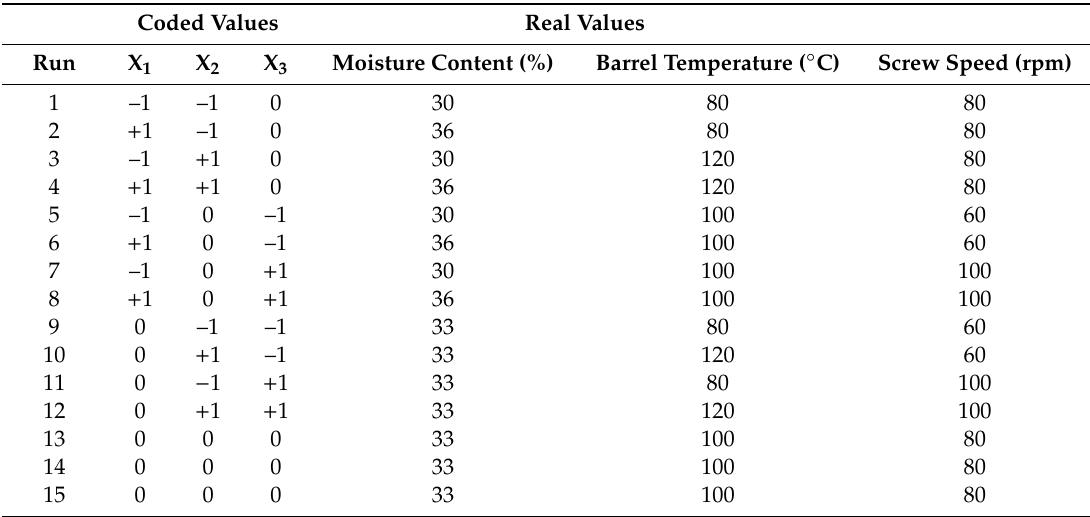
Table 1. Box-Behnken experimental design with coded and real values of extrusion-cooking variables. Coded